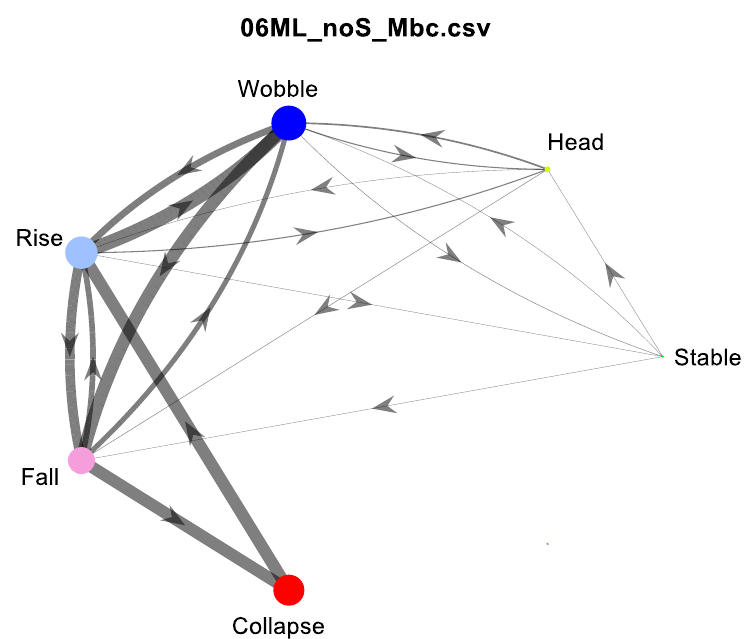
Figure 5. Model of postural development showing stages (colored circles), amount of time spent in each stage (relative size of circles), transitions between states (lines with arrows), and frequency of transitions coming from each node (line thickness). In this example, the child spent most time in Wobble, Rise and Fall, and Collapse and frequently transitioned from Rise to Wobble, Wobble to Fall, Fall to Collapse, and Collapse to